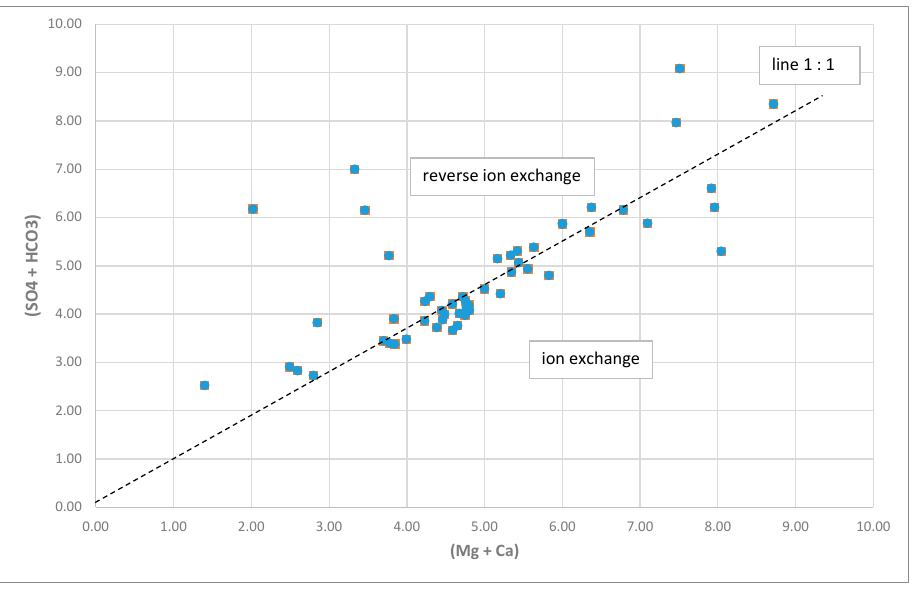
Figure 10. Plot of (Ca + Mg) and (SO 4 + HCO 3 ) in meq/L.